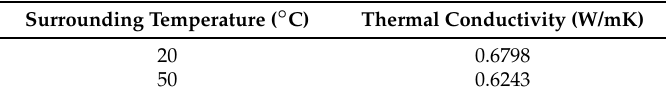
Table 2. Thermal conductivity of G-class cement specimen.